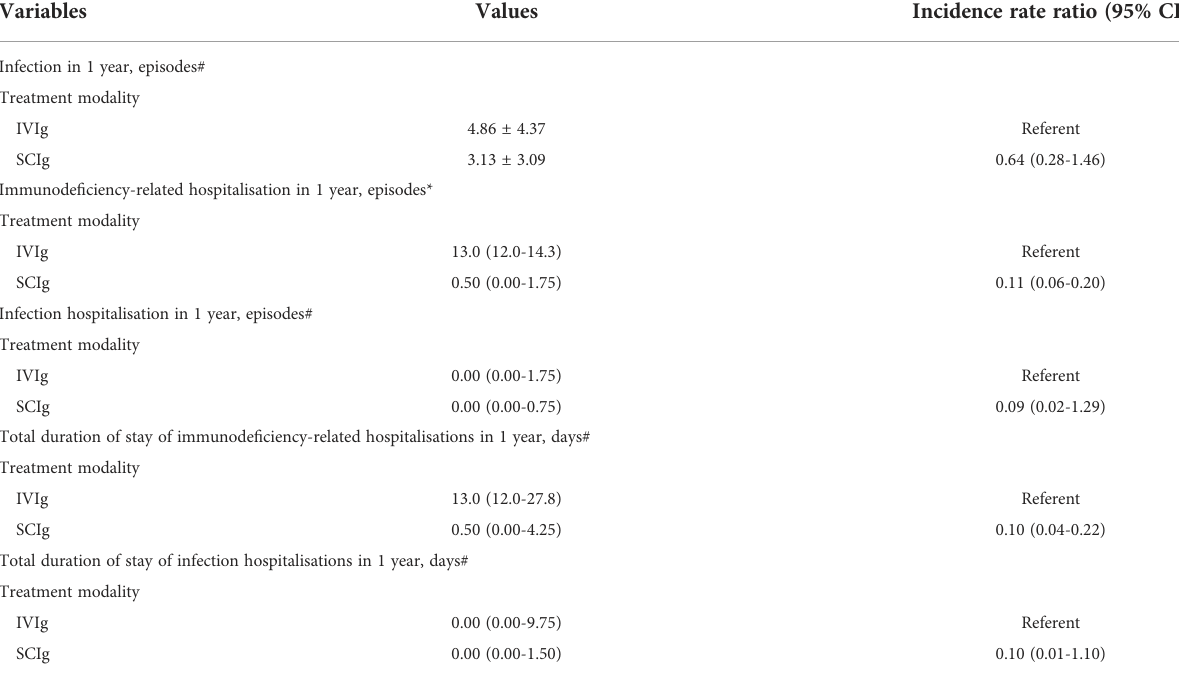
TABLE 2 Infection and hospitalisation outcomes of patients on regular IVIg and SCIg replacement.